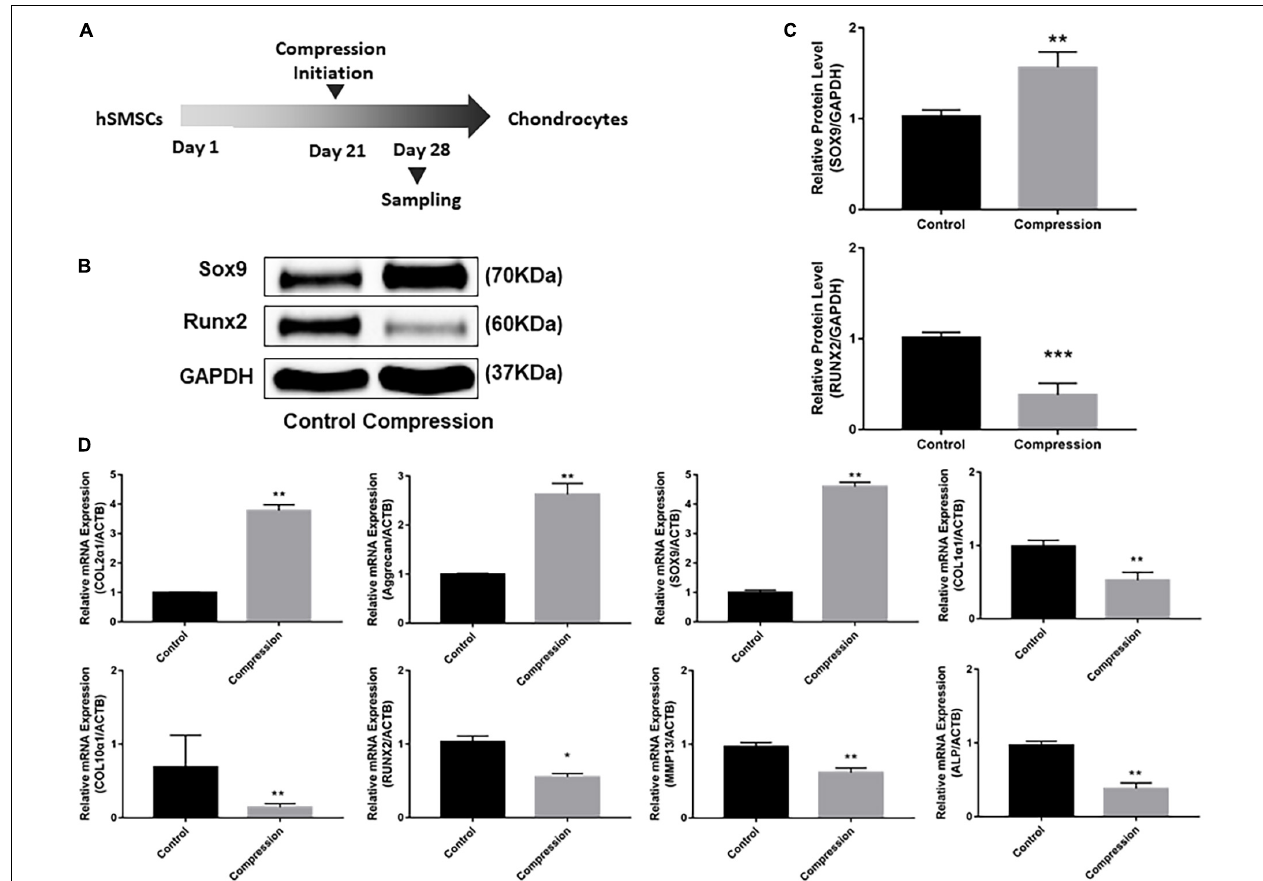
FIGURE 5 | Dynamic compression applied after 3-week chondrogenic induction led to the promotion of chondrogenesis as well as the suppression of hypertrophy development of SMSCs. (A) Schematic of the experimental protocol. (B) Western blot analysis of expression levels of SOX9 and RUNX2 at day 28. (C) Expression levels of SOX9 and RUNX2 were shown in the histograms normalized with GAPDH. (D) Gene expression of chondrogenesis and hypertrophy development. Results are presented as the mean ± S.D. * P < 0.05, ** P < 0.01, *** p < 0.001. COL2 α 1, collagen type II; SOX9, SRY-box transcription factor 9; COL1 α 1, collagen type I; COL10 α 1, collagen type X; RUNX2, RUNX family transcription factor 2; MMP13, metalloproteinases 13; ALP, alkaline